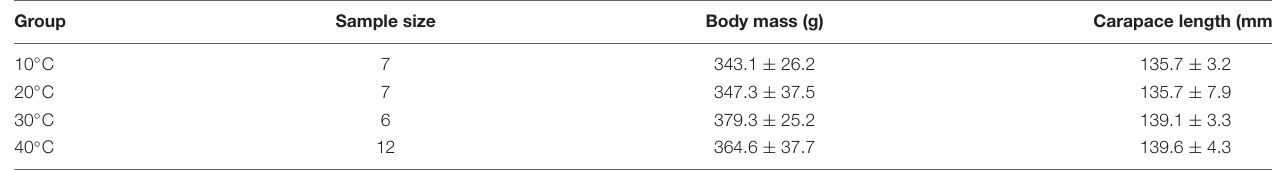
TABLE 1 | Comparison of the body mass and carapace length of Trachemys scripta elegans among the temperature groups. Group